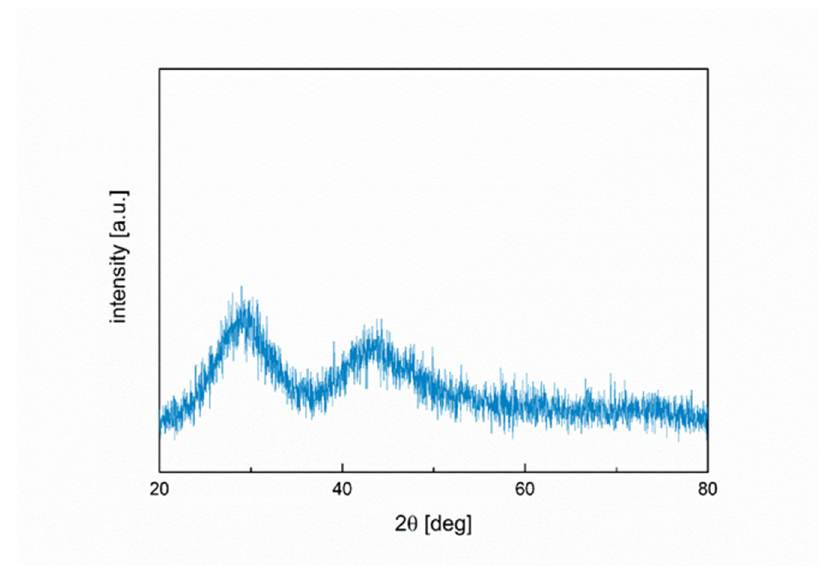
Figure 2. Microstructure and histogram of the grain size distribution of glass powder Schott GM31107 ( a – c ) and YSZ powder ( d – f ).